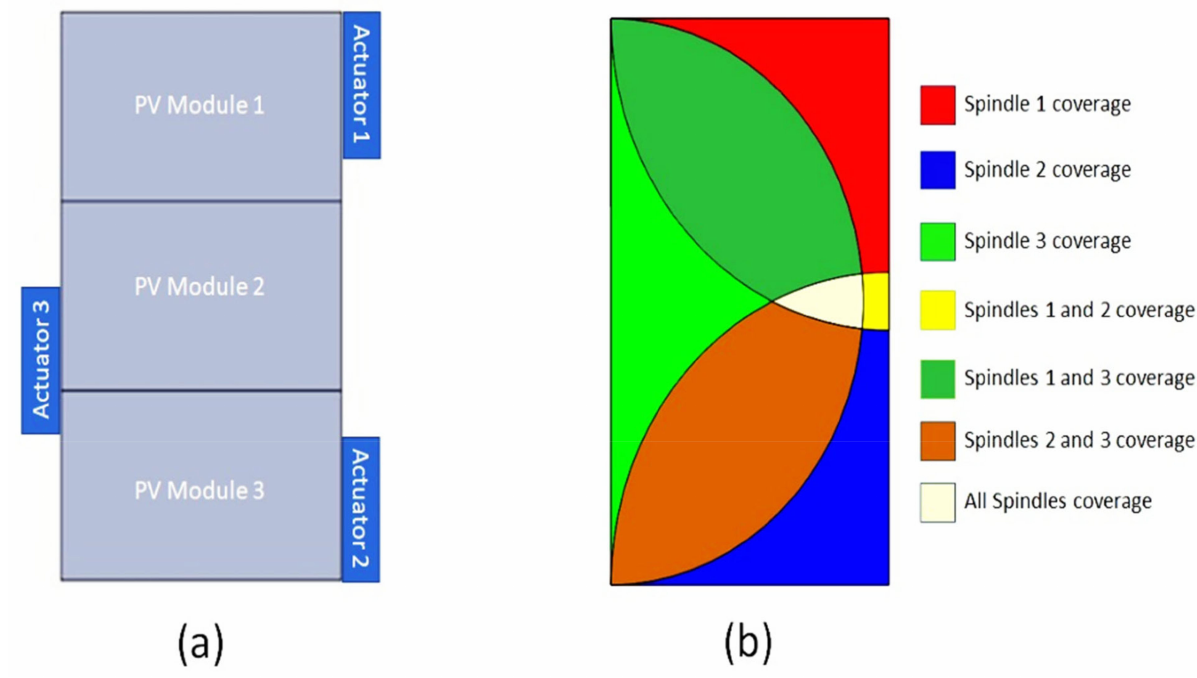
Figure 5. ( a ) Arbitrary CAD example of dusty PV modules string, and ( b ) coverage area of multiple actuator arrangements used for